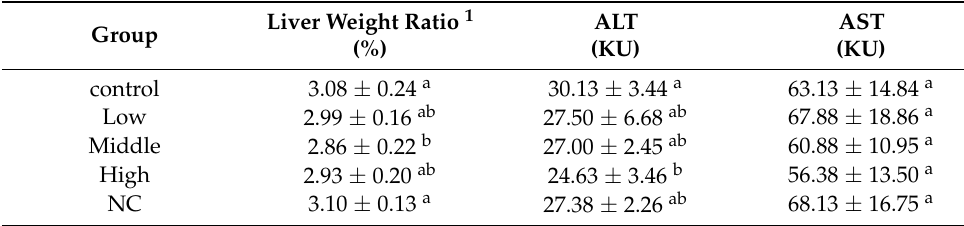
Table 1. The effects of EUAJ (3:1) on liver damage in SD rats.